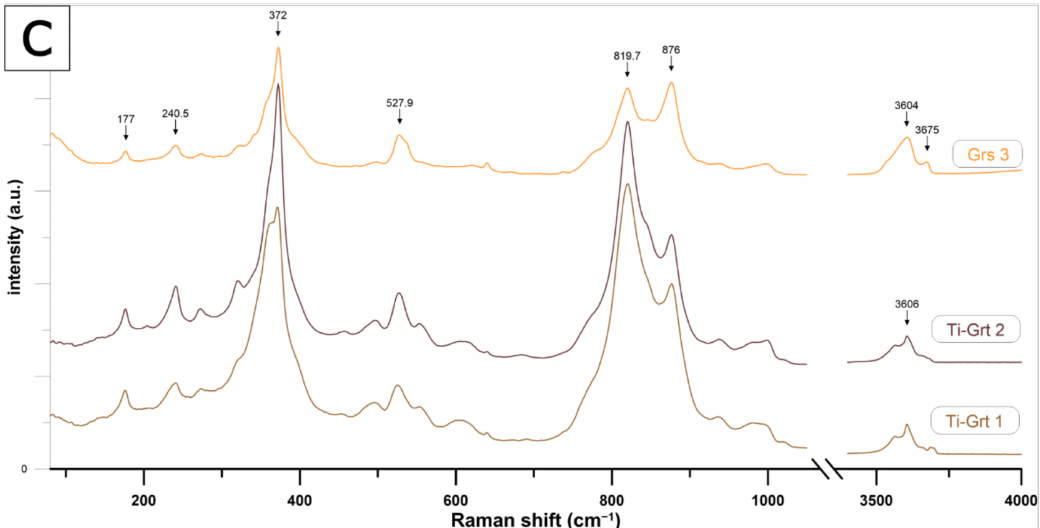
Figure 7. Raman spectra of analyzed garnets demonstrating the different degree of hydration, uncorrected; ( a ) Spectra corresponding to the spots in Figure 3; ( b ) Spectra corresponding to the spots in Figure 4a; ( c ) Spectra corresponding to the spots in Figure 4b.